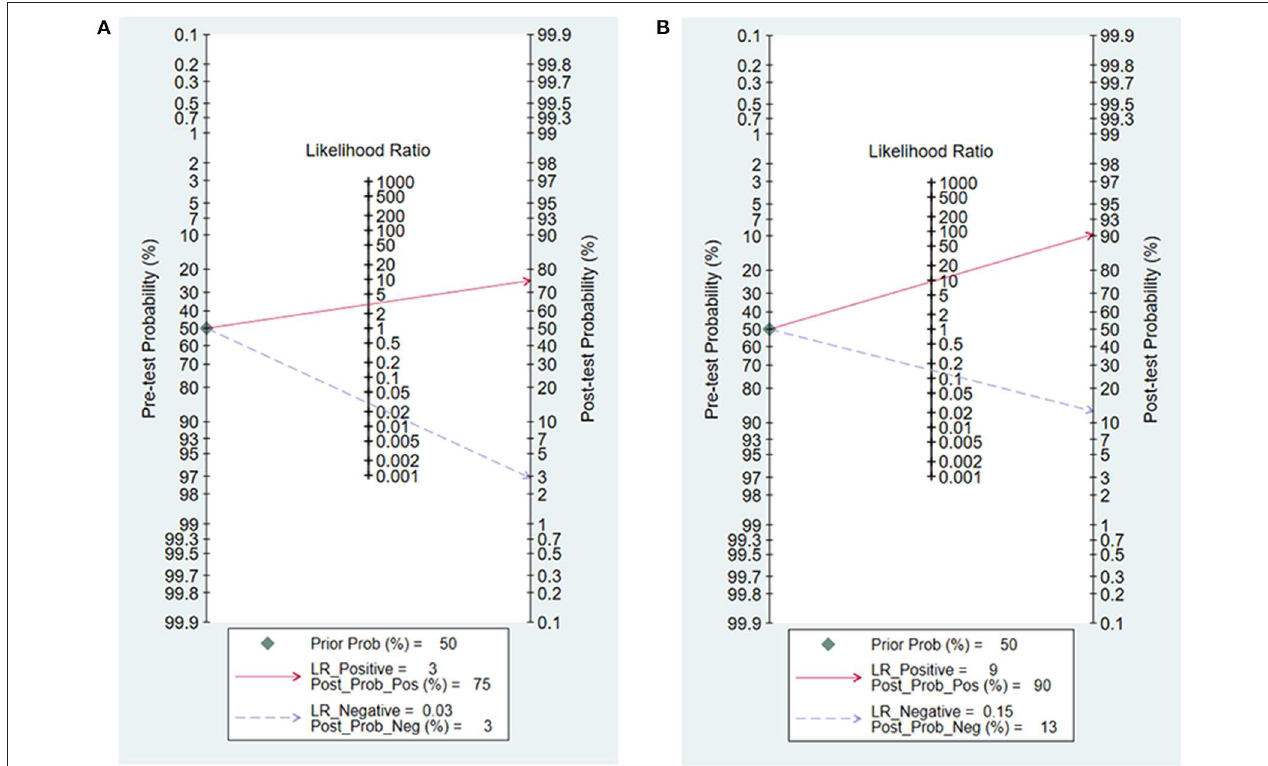
FIGURE 8 | Fagan nomogram for the uptake change ratio (A) and washout rate (B) of 99m Tc-MIBI scintigraphy in preoperatively assessing the response of osteosarcoma patients to neoadjuvant